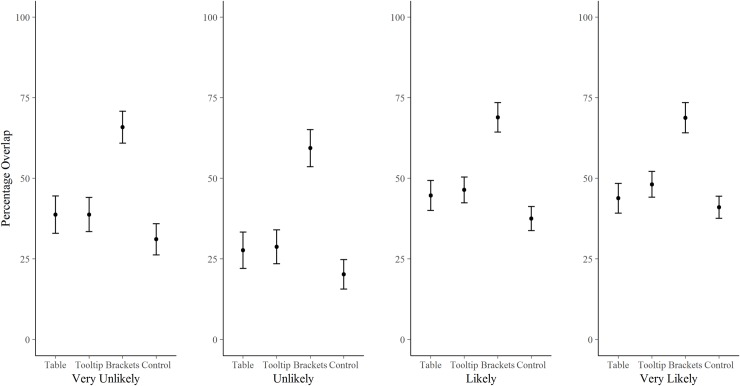
Percentage overlap of participants’ interval judgements in each condition with the respective ranges specified in the ICD 203 guidelines.Results are separated out for each of the four verbal probability phrases.